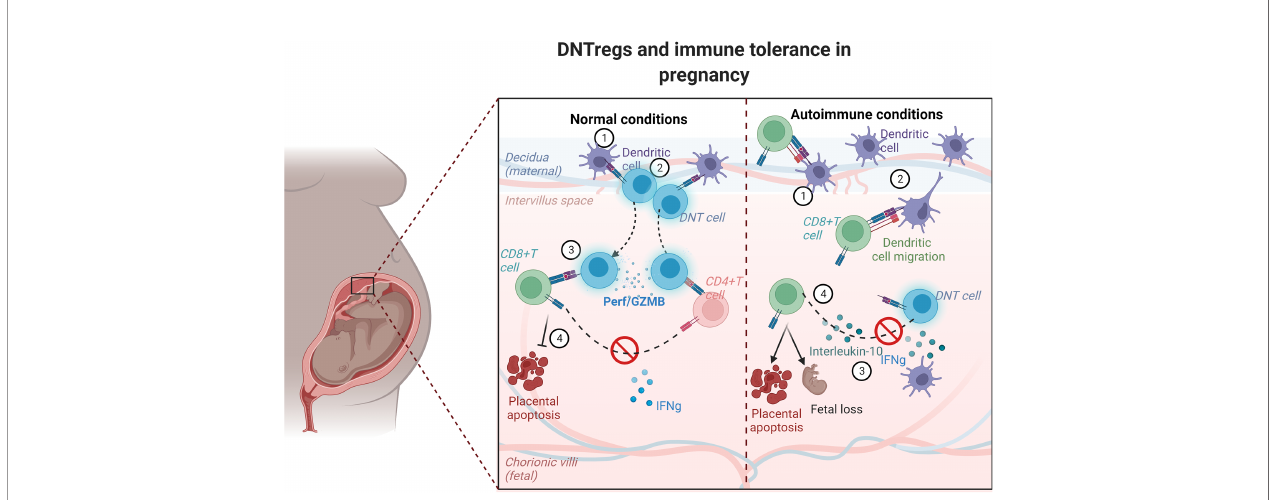
FIGURE 2 | Schematic model showing trogocytosis mechanism by DNTregs in maintaining tolerance in pregnancy. DNTregs utilize trogocytotic mechanisms to suppress recognition of fetal antigens by effector cells and thus prevent placental degeneration and apoptosis in normal physiologic conditions. However, in autoimmune conditions DNTreg populations decrease, and the maternal effectors gain access to the semi-allogenic placenta and induce apoptosis with consequent fetal rejection. The numbers in each panel indicate the sequential progression of interactions between dendritic cells, DNTregs, and effector T cells under normal and autoimmune conditions. Perf = perforin; GZMB= granzyme (B) Figure created using Biorender.com